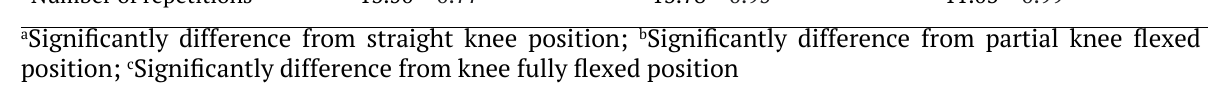
Table 4. The number of chin-up repetitions using three positions Variable Straight knee Partial knee flexed Knee fully flexed Number of repetitions 13.50 ± 0.77 c 13.78 ± 0.95 c 11.03 ± 0.99 ab